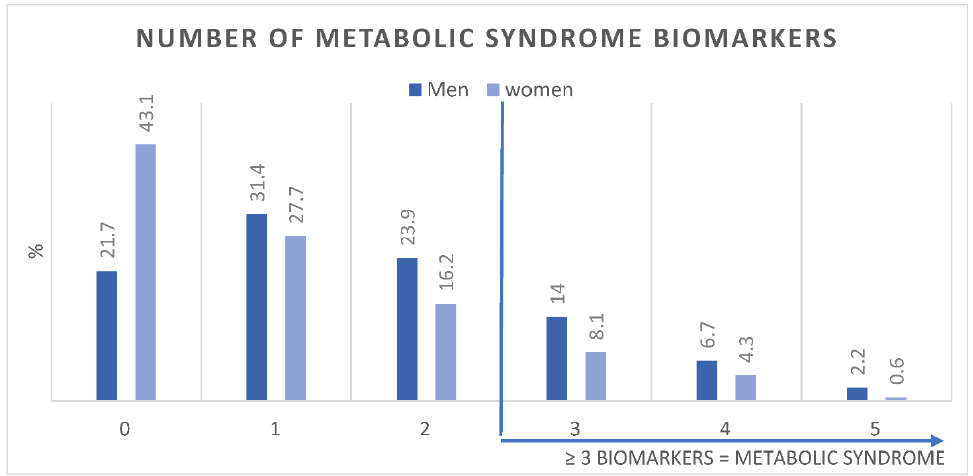
Figure 2. Age ‐ adjusted Prevalence (%) of number of metabolic syndrome biomarkers in men ( n = 3196) and women ( n = 19,651). Multivariate logistic regression analyses were used to test the association of specific determinants with having MetS in men and women, as presented in Tables 5 and 6, respectively. Age, increased BMI, and family history of heart disease and/or any metabolic abnormality were found consistently associated with an increase in the odds of having MetS in both men and women.